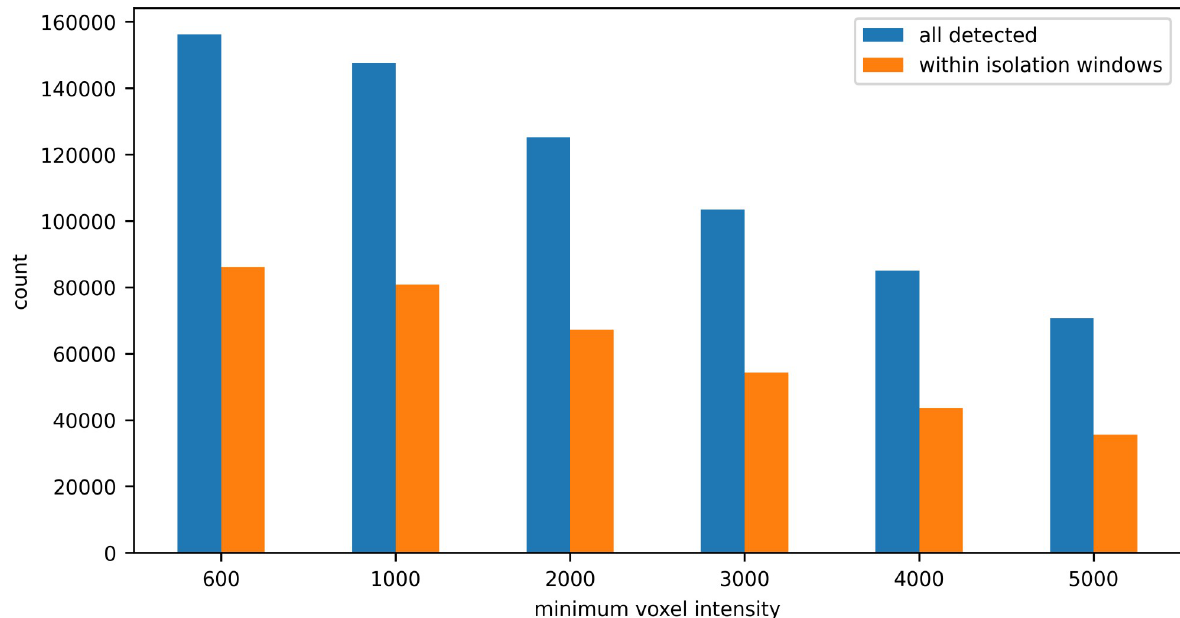
Fig 8. Number of all features detected compared to the number of features within isolation windows, by minimum voxel intensity.